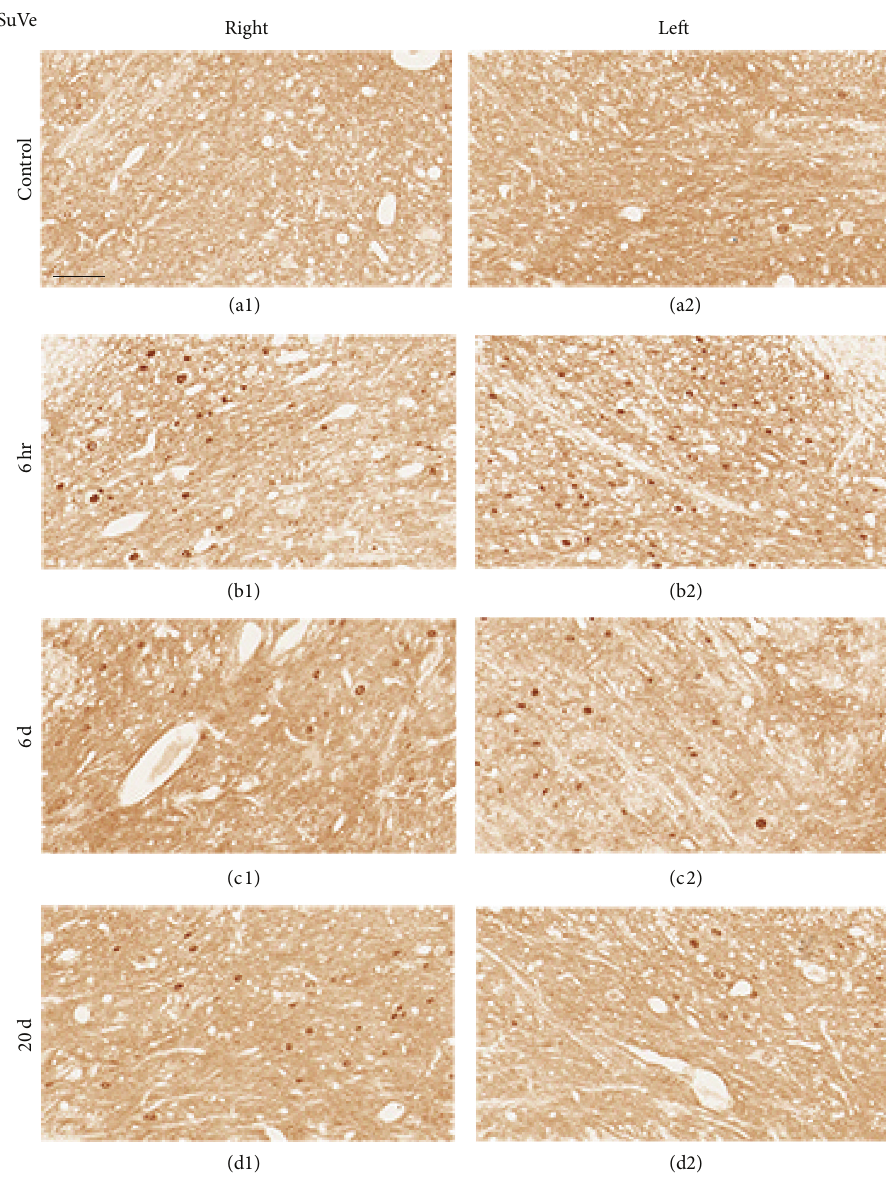
Figure 7: Representative photomicrographs showing c-Fos immunoreactivity in the SuVe (Bregma − 11.60mm) of rats that underwent cochleostomy at 1 and 3 hours and 6 and 20 days. Bilaterally increased c-Fos-positive cells were observed at 6 hours (b1 and b2), 6 days (c1 and c2), and 20 days (d1 and d2) relative to controls (a1 and a2). (a1), (b1), (c1), and (d1): right side; (a2), (b2), (c2), and (d2): left side. Scale bar = 40 𝜇